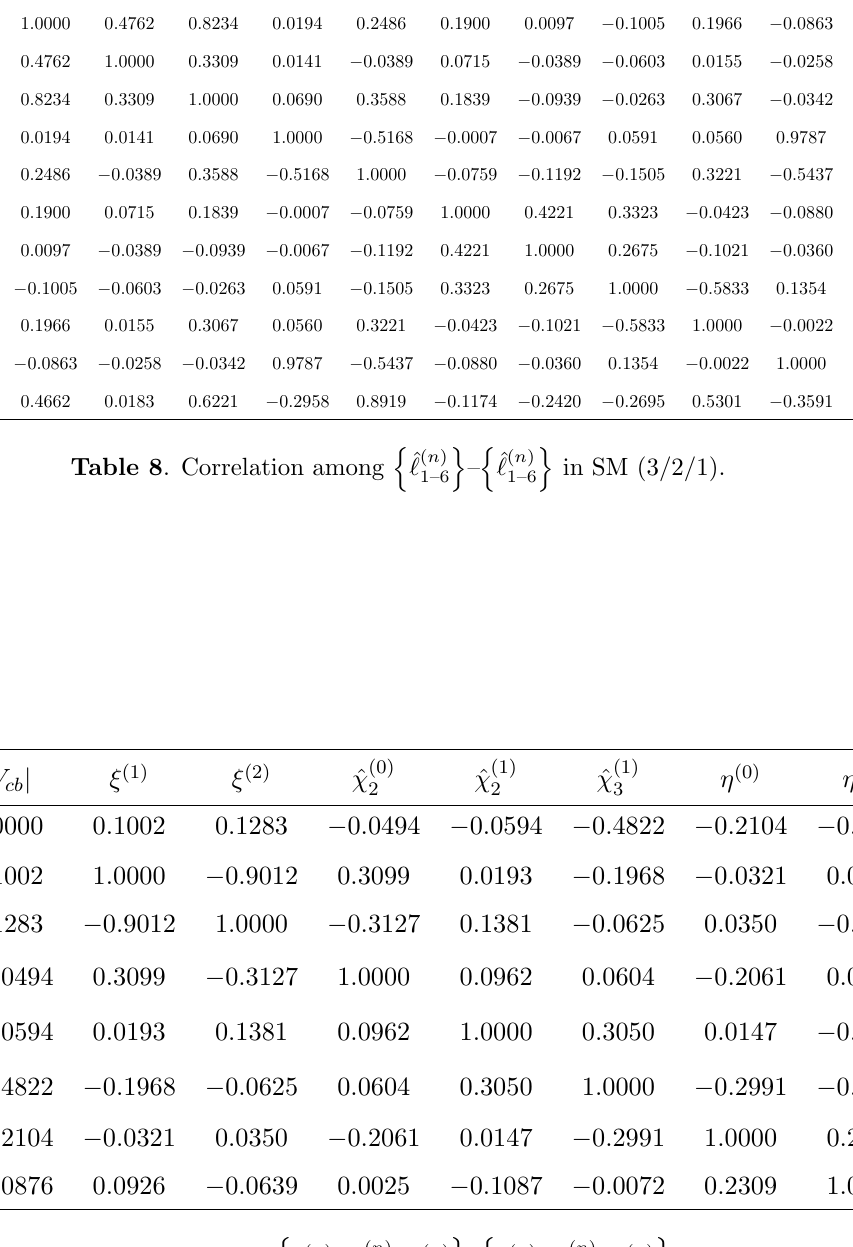
Table 9 . Correlation among